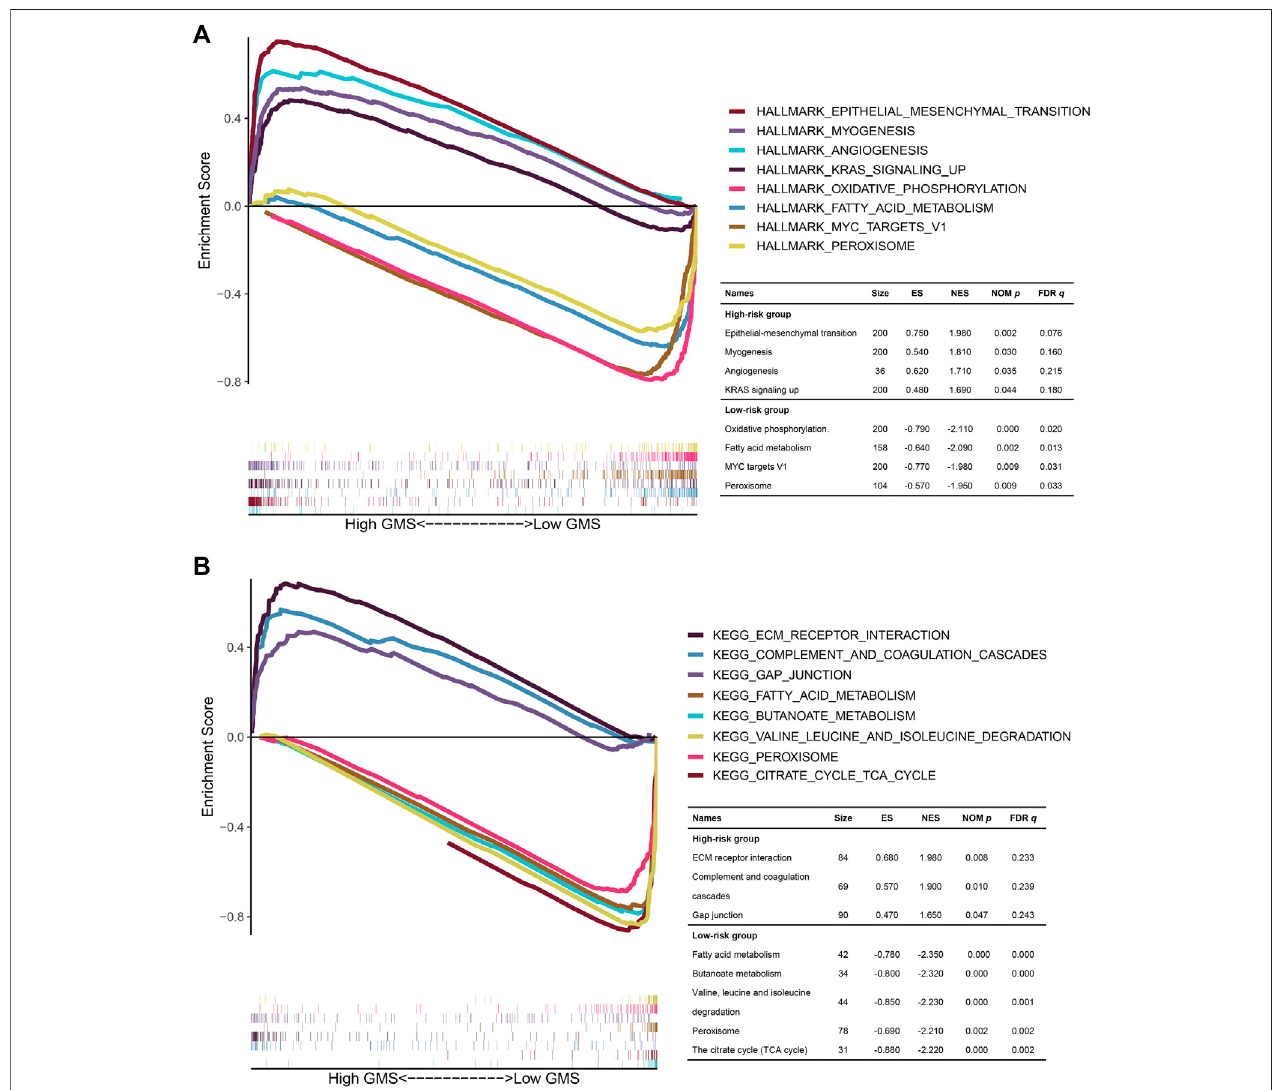
FIGURE 10 | The GSEA for the TCGA CRC patients in the high- and low-risk groups. (A,B) : The multi-GSEA plots depicting the hallmark and KEGG functional pathways enriched in the gene matrices of TCGA CRC patients in the high- and low-risk groups. The curves above the X-axis represented the functional pathways enriched inthegenematricesofTCGA CRC patients inthe high-riskgroup. Correspondingly,thecurvesbelowtheX-axis representedthefunctionalpathwaysenriched in the gene matrices of TCGA CRC patients in the low-risk group.